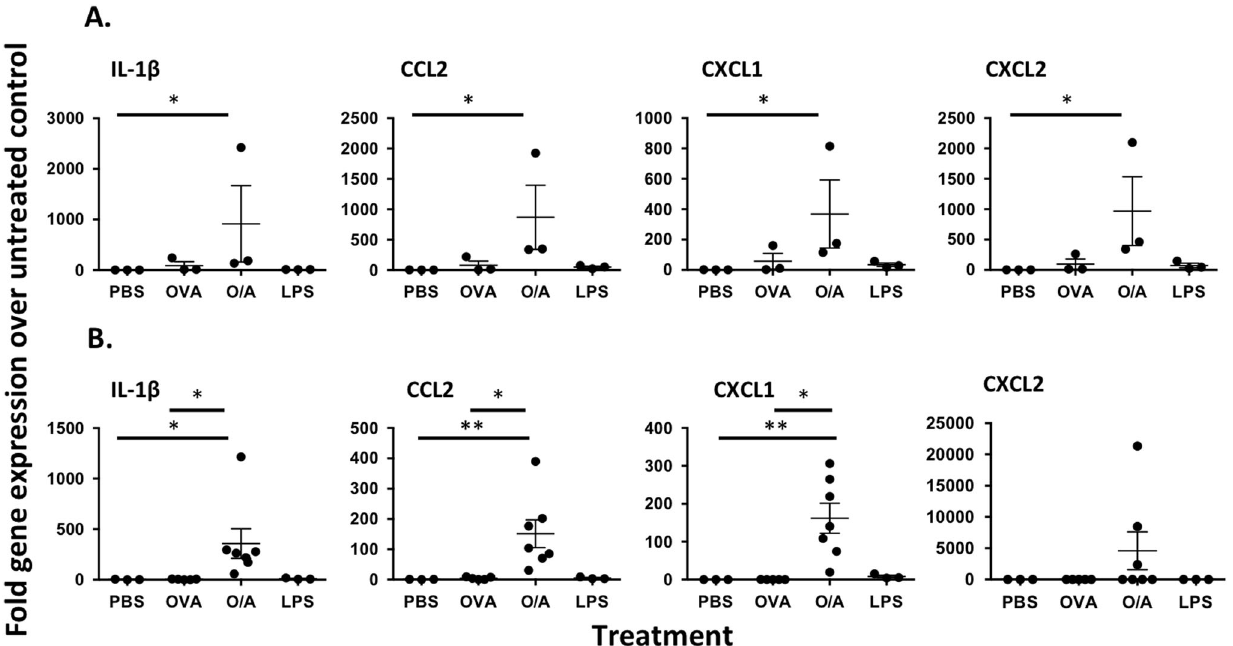
Fig. 2 In fl ammatory chemokine and cytokine expression at the site of immunisation and dLN 2 h after Alum injection. Representative examples of in fl ammatory chemokine and cytokine expression at a the site of alum injection (three animals per group) and b draining cervical lymph nodes (three to seven animals per group). Data are representative of two independent experiments. *P < 0.05, ** P <